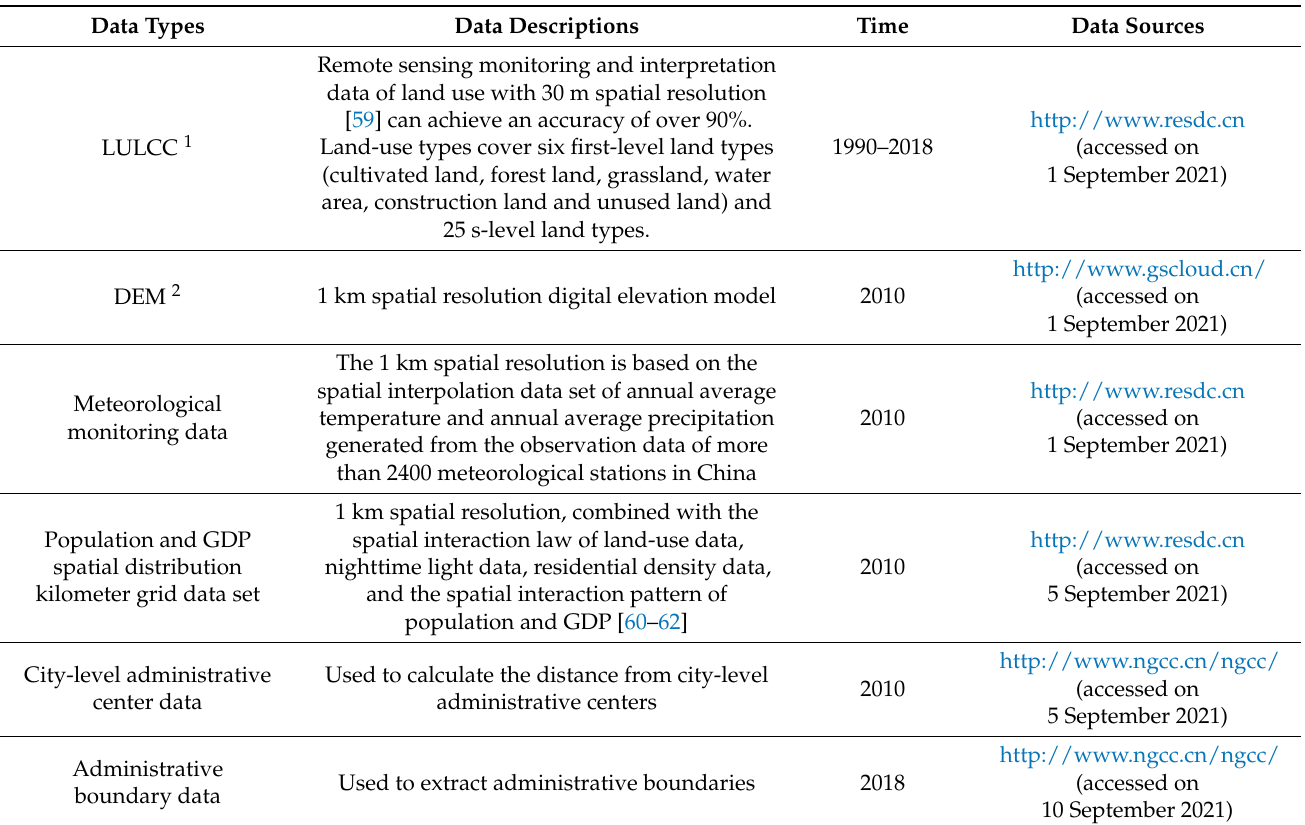
Table 1. Data sources and